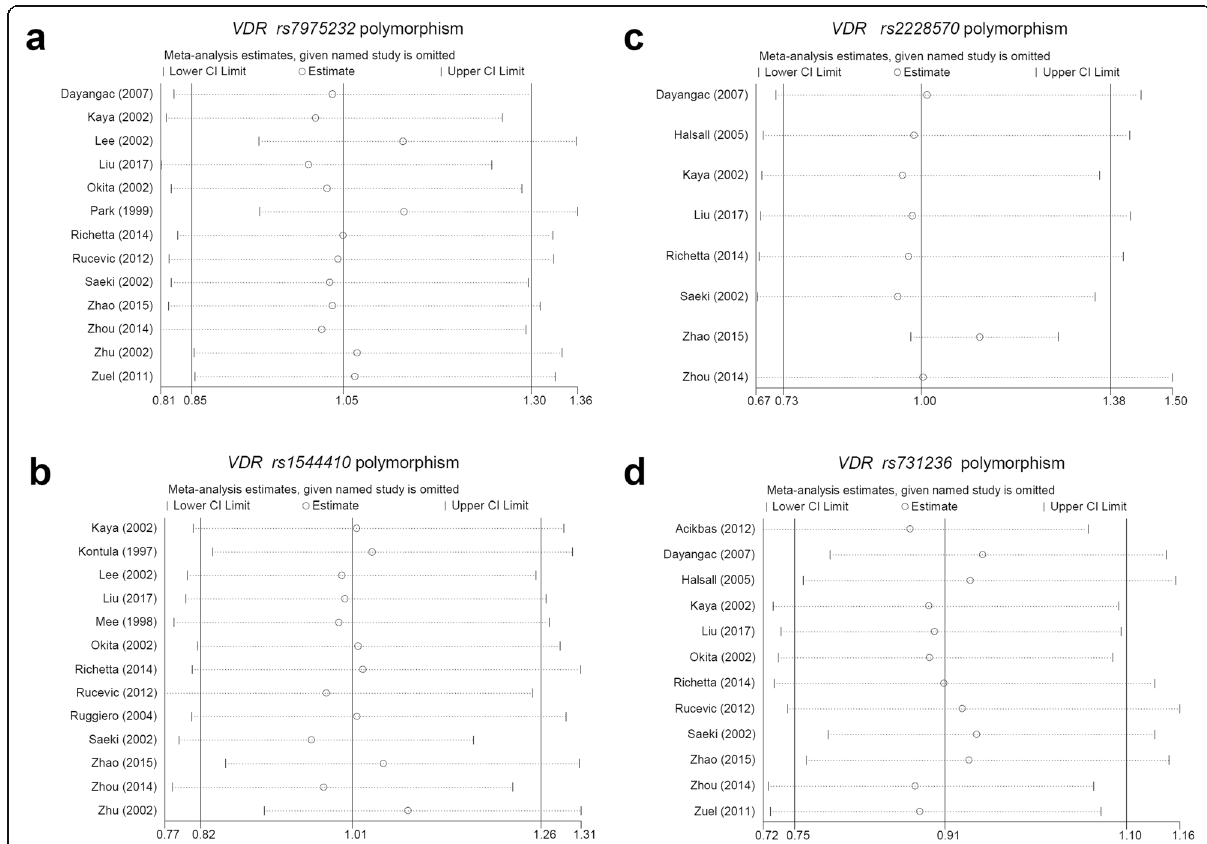
Fig. 6 Sensitivity analysis result under the allele model. a rs7975232 polymorphism; b rs1544410 polymorphism; c rs2228570 polymorphism; d rs731236